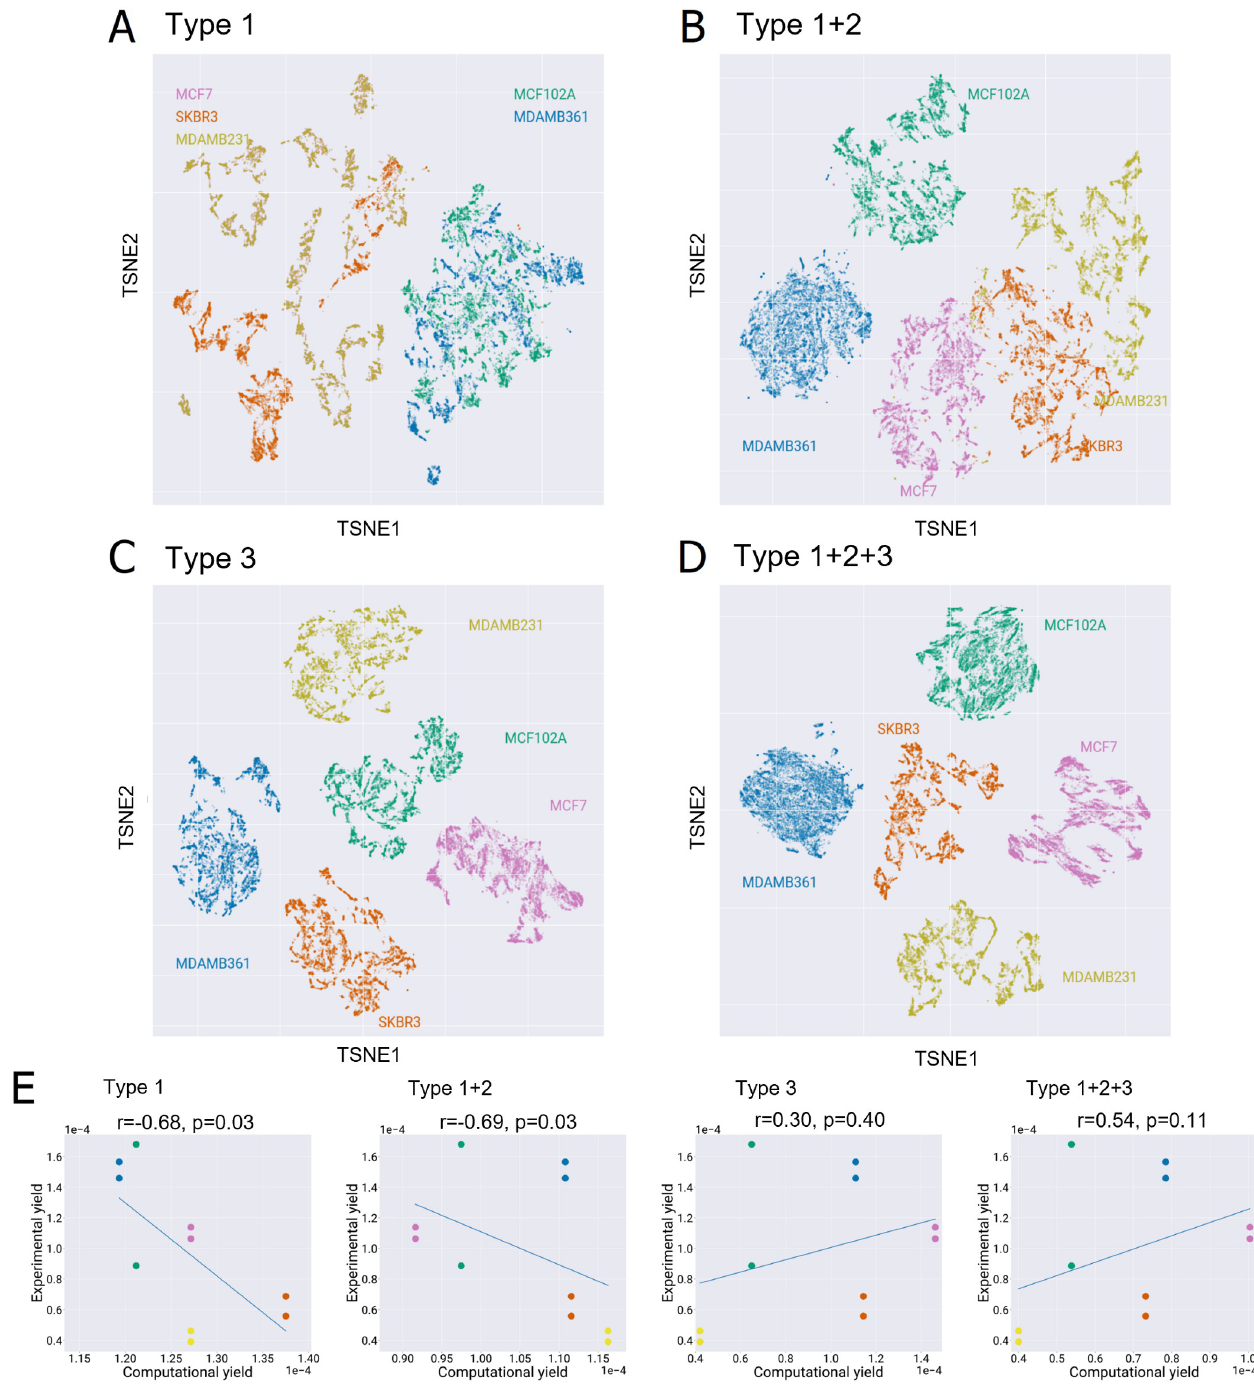
Fig 3. Evaluation of the effect of the different types of constraints on ENGRO2 feasible solutions. Effect of constraints on A) nutrients availability (type 1), B) nutrients availability and extracellular fluxes (type 1+2), C) intracellular fluxes based on transcriptomics data (type 3) and all together (type 1+2+3) in segregating the five investigated cell lines. A two-dimensional map of the FFDs of the five cell lines in each setting is shown. For reversible reactions, that net flux is considered. For computational reasons, only 10000 steady-state solutions sampled within the feasible region of each model were plotted. E) Correlation between the experimental and in silico growth yield on glucose is reported for each of the four settings in panels A, B, C and D. The Spearman correlation coefficient and p-value are reported on top of each plot.